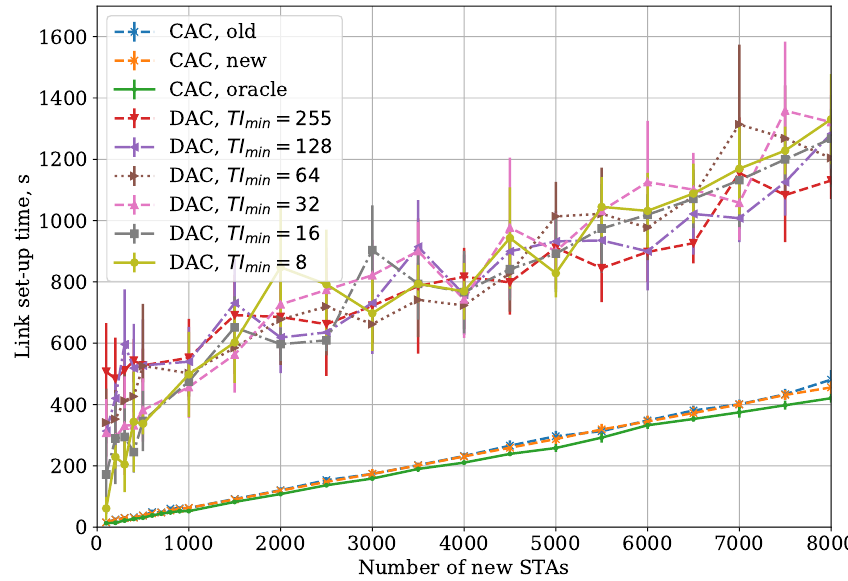
Figure 10. CAC and DAC protocols: dependency of the link set-up time on the number of new STAs for the Two Groups case with Capture